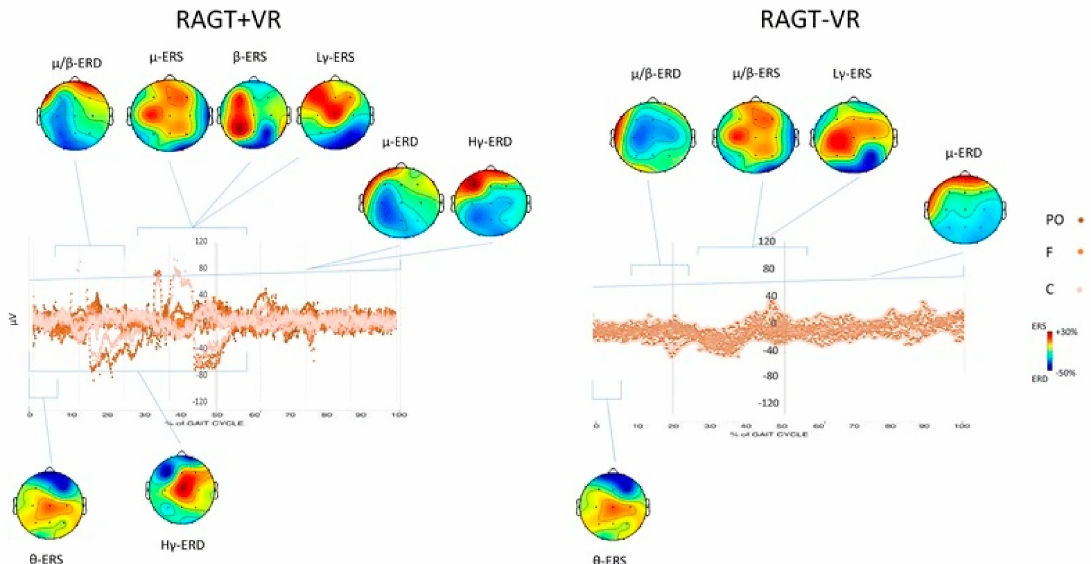
Figure 4. Average changes at second day of the first week of treatment (T POST ) as compared to last day of the last week of treatment (T PRE ) in scalp Event-Related Potential (ERP) projections relatively to the full gait cycle. The left and right hemispheres plots correspond to the affected and unaffected ones, respectively. Event-related synchronization (ERS) and Event-related de-synchronization (ERD) are masked in red and blue tones, respectively, whereas nonsignificant differences are in green. All rights reserved, with permission from Springer Nature. Reference